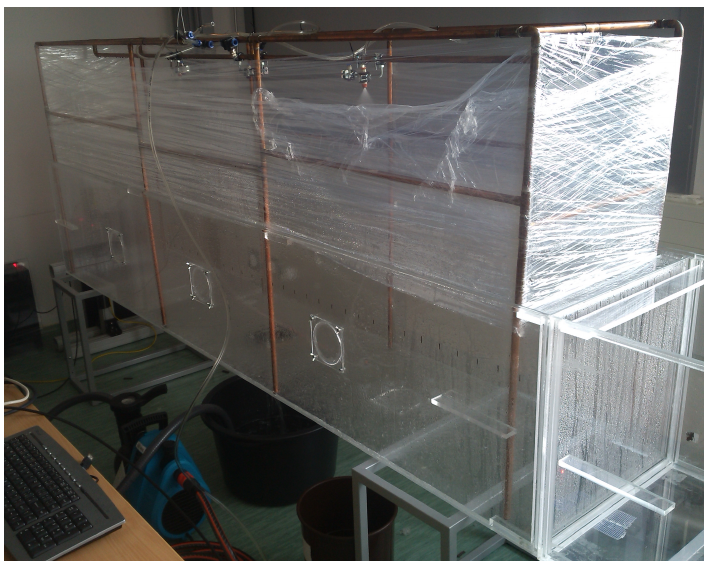
Figure 23. Photo of setup for scenario 3 and 4—rain.